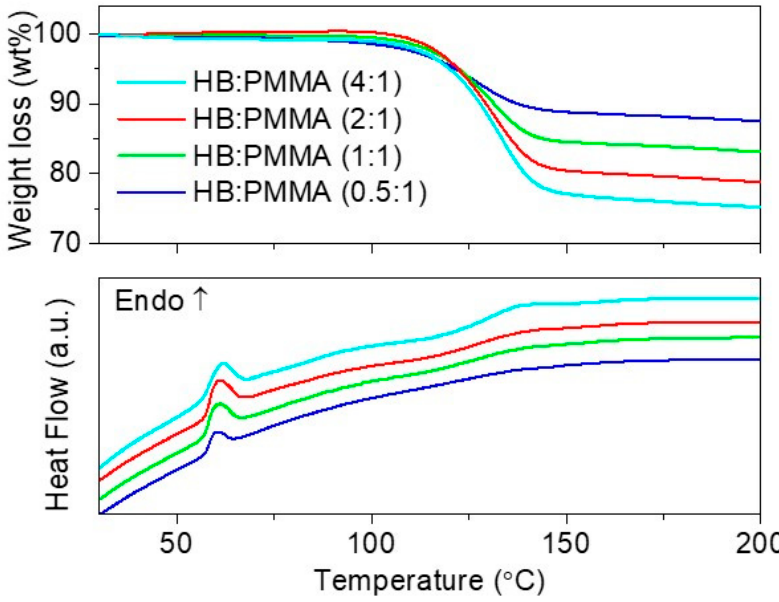
Figure 10. TGA-DTA results of HB:PMMA at different HB loading.